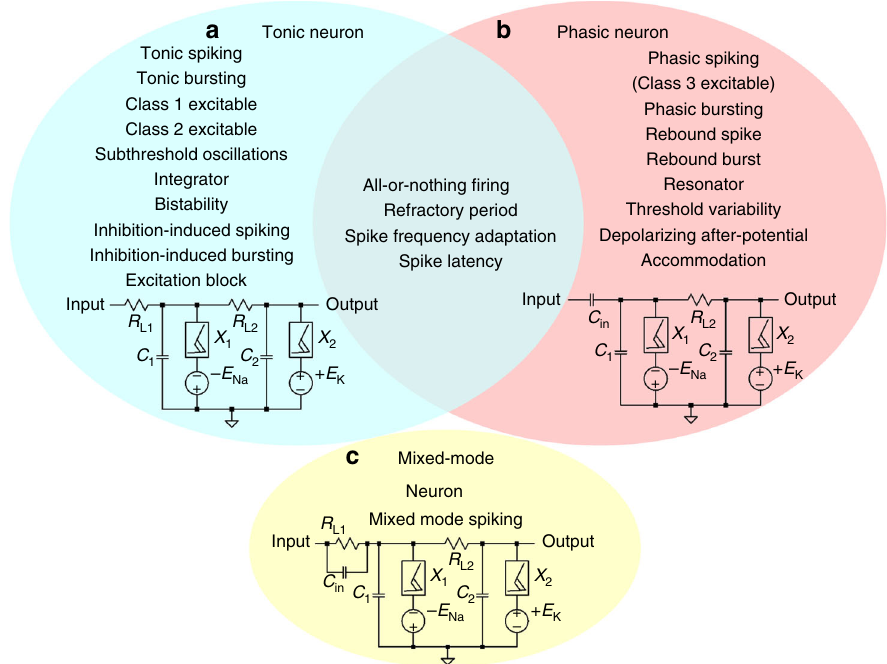
Fig. 3 Three active memristor prototype neuron circuits and their experimentally demonstrated spiking behaviors. a Tonic excitatory neurons, with a resistive coupling to dendritic inputs, show tonic spiking (Supplementary Fig. 13), tonic bursting (Supplementary Fig. 14), Class 1 excitable (Fig. 4g), Class 2 excitable (Fig. 4h), subthreshold oscillations (Supplementary Fig. 18), integrator (Supplementary Fig. 19), bistability (Supplementary Fig. 20), inhibition- induced spiking (Supplementary Fig. 21), inhibition-induced bursting (Supplementary Fig. 22), and excitation block (Supplementary Fig. 23). b